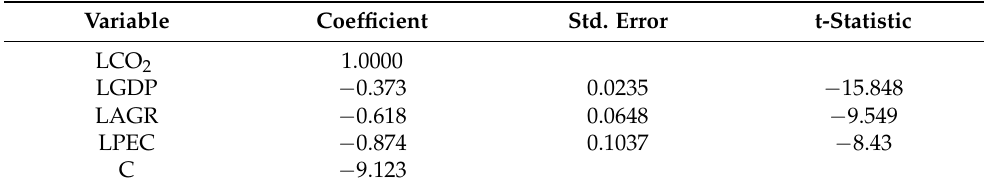
Table 5. Long-run